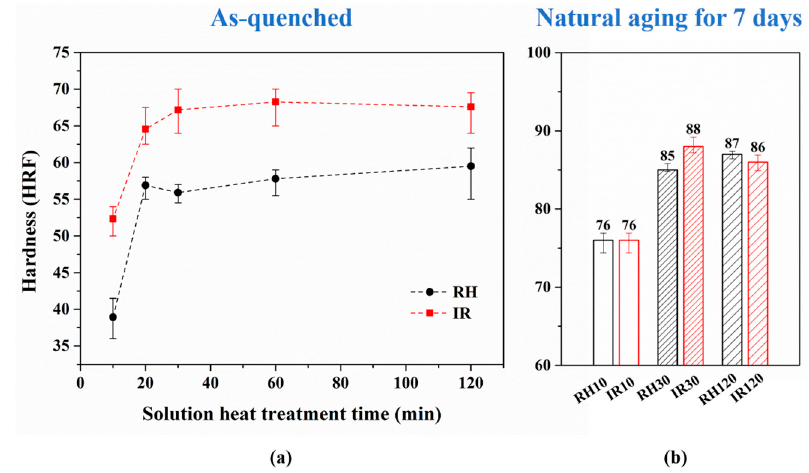
Figure 4. Hardness of various heat-treated specimens of ( a ) as-quenched; ( b ) natural aging for 7 days.